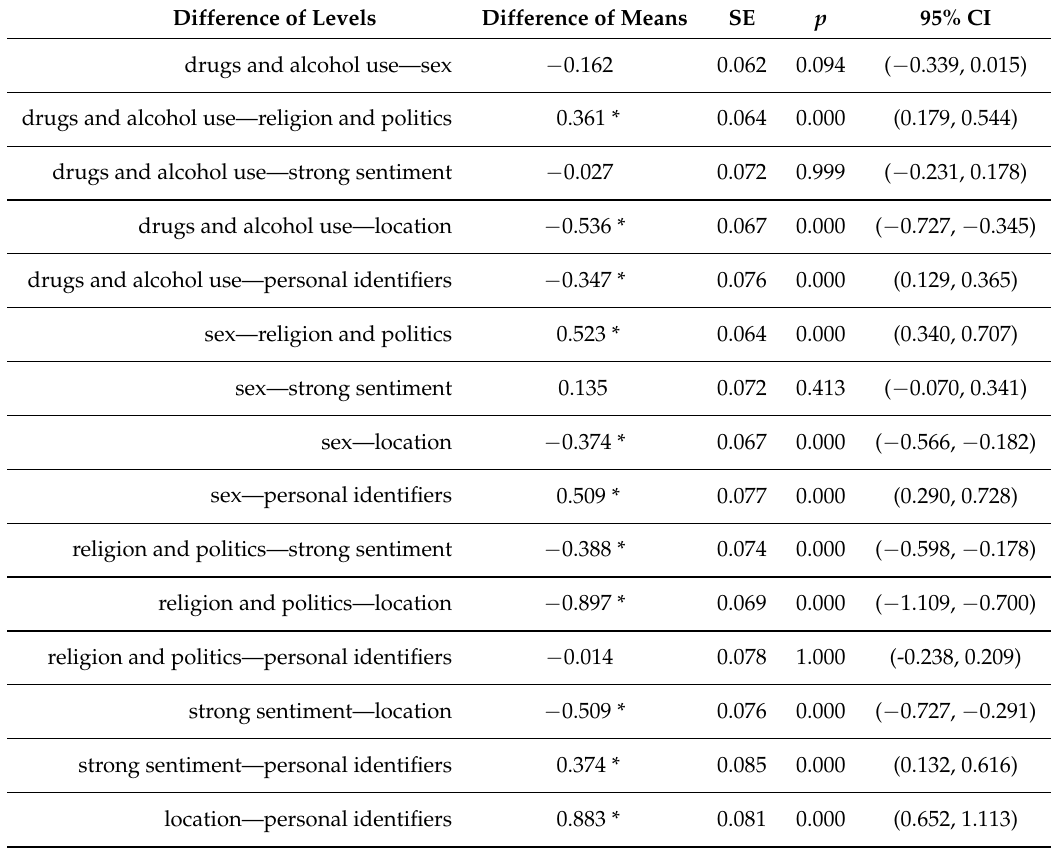
Table A4. Games-Howell Simultaneous Tests for Differences of